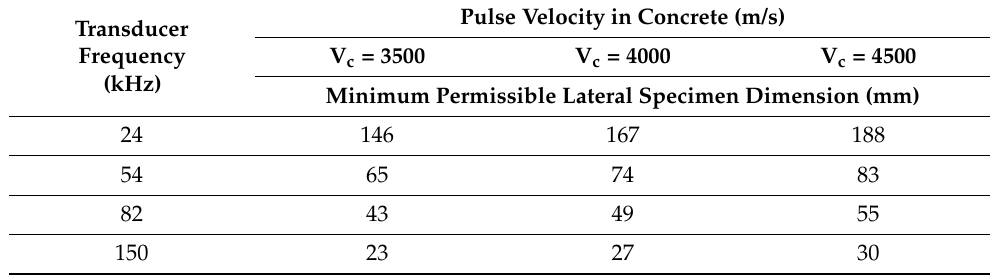
Table 6. Effect of sample dimensions of pulse transmission (BS 1881: Part